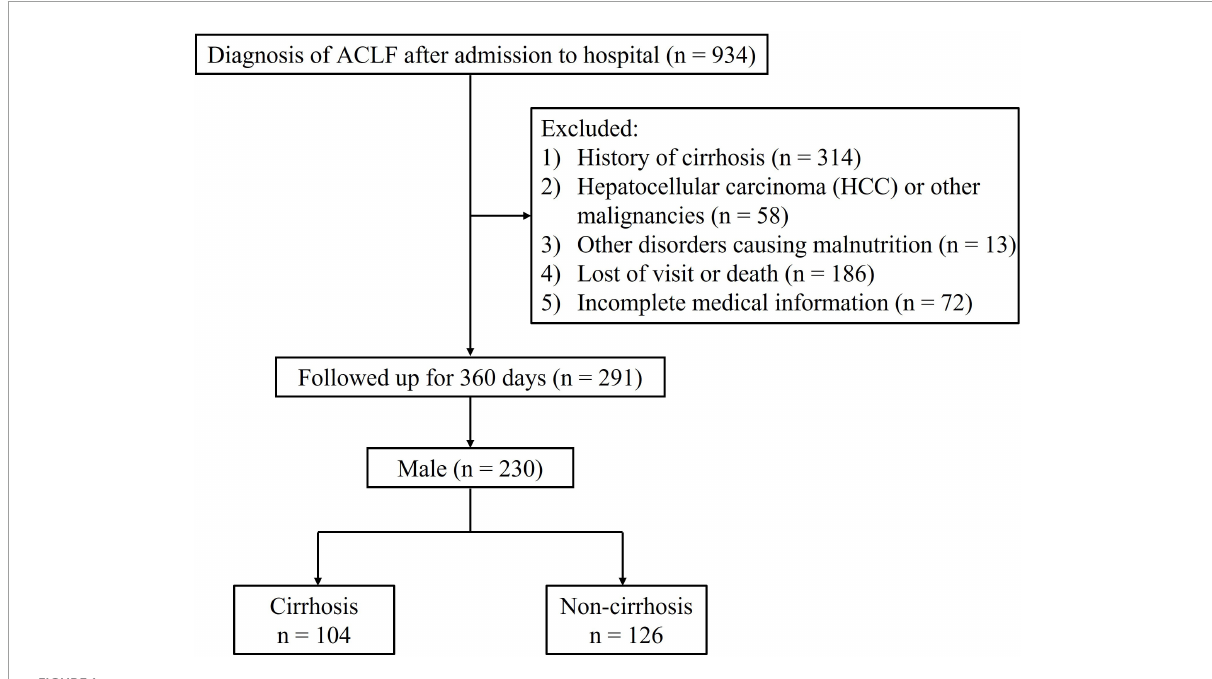
FIGURE1 Study flow diagram. ACLF, acute-on-chronic liver